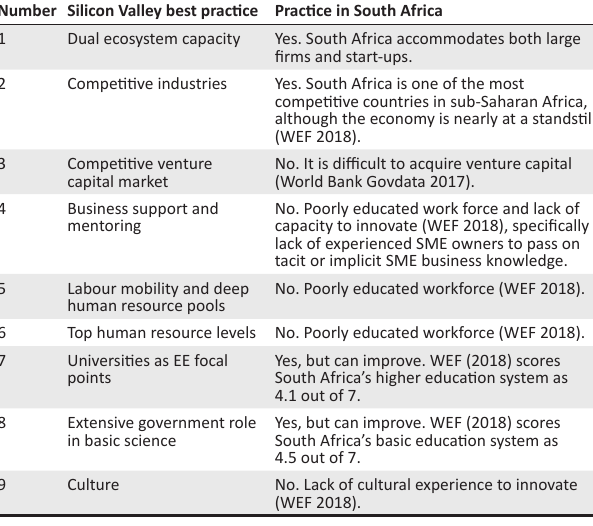
TABLE 2: Comparison between the Silicon Valley entrepreneurial ecosystems and the South African entrepreneurial ecosystems. Number Silicon Valley best practice Practice in South Africa Dual ecosystem